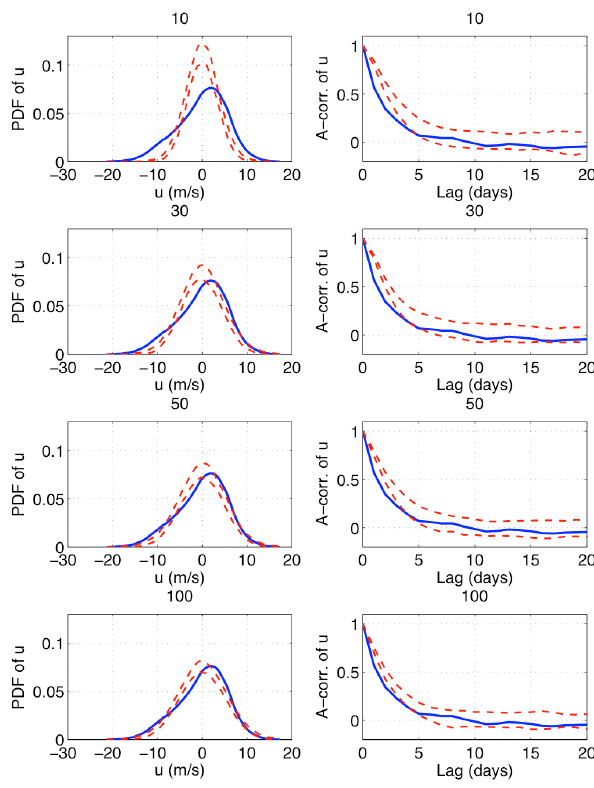
Figure 7. Probability density function (PDF; left panels) and autocorrelation function (ACF; right panels) of the observed and simulated zonal velocity anomalies at 120ºW and 55ºS. Solid lines: the observed functions; dashed lines: 95% spread based on SLW-only model with quadratic main level. The four rows show the results, from top to bottom, for the models constructed in the subspace of 10, 30, 50, and 100 PCs of SLW, respectively.